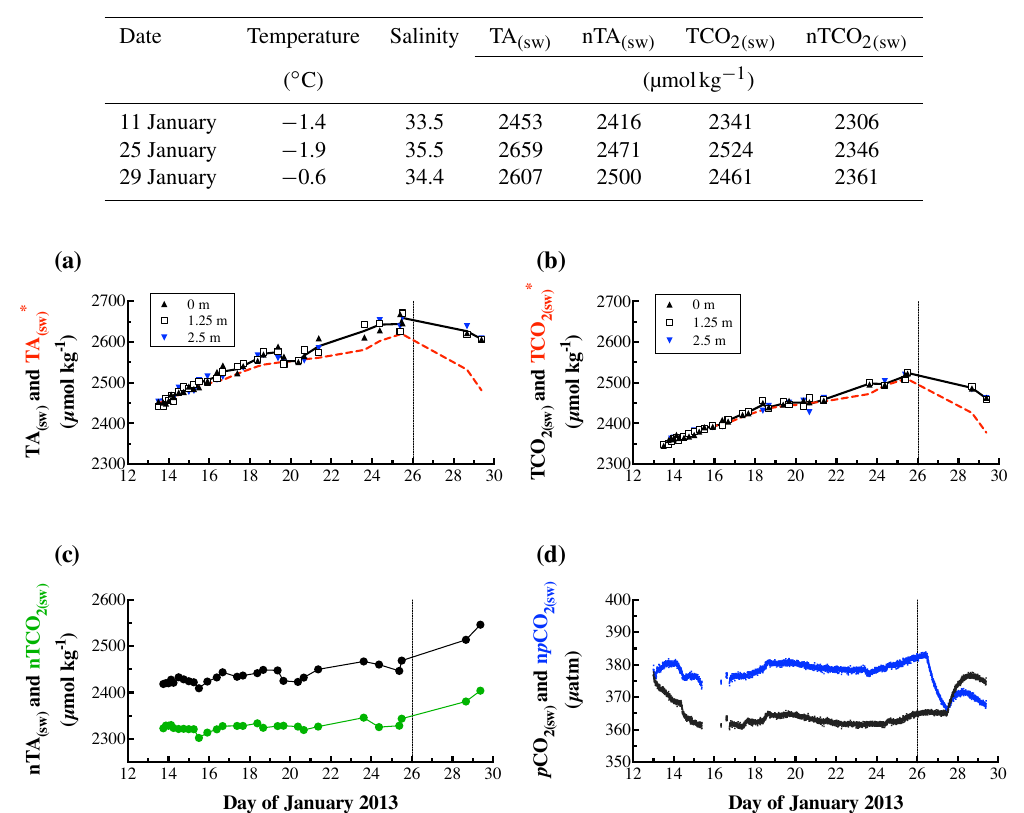
Figure 3. Evolution of (a) TA (sw) and TA ∗ (µmolkg − 1 ), (b) TCO 2(sw) and TCO ∗ (µmolkg − 1 ), (c) nTA (sw) (black) and nTCO 2(sw) (sw) 2(sw) (green) (µmolkg − 1 ) and (d) the seawater p CO 2 (µatm) measured in situ (black) and corrected to a constant temperature of − 1 ◦ C (blue). In panels (a) and (b) the black line is the average over the three depths, while the dotted red line is the expected concentrations according to the variation of salinity observed and calculated from the mean values of the three depths (TA ∗ and TCO ∗ , respectively). The vertical (sw) 2(sw) black dotted line on 26 January marks when the heat was turned back